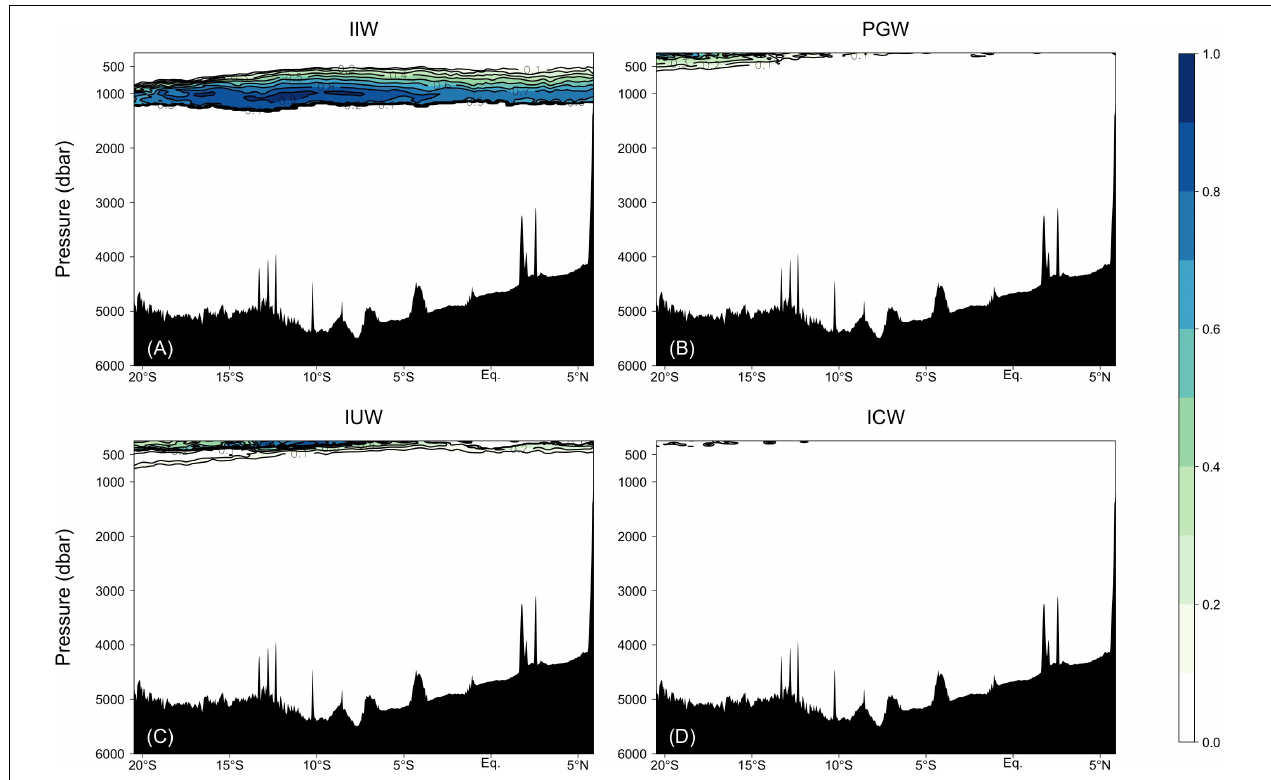
FIGURE 5 | Fractions of the water masses confirmed by the water mass analyses: (A) IIW, (B) PGW, (C) IUW = UIUW + LIUW, and (D)